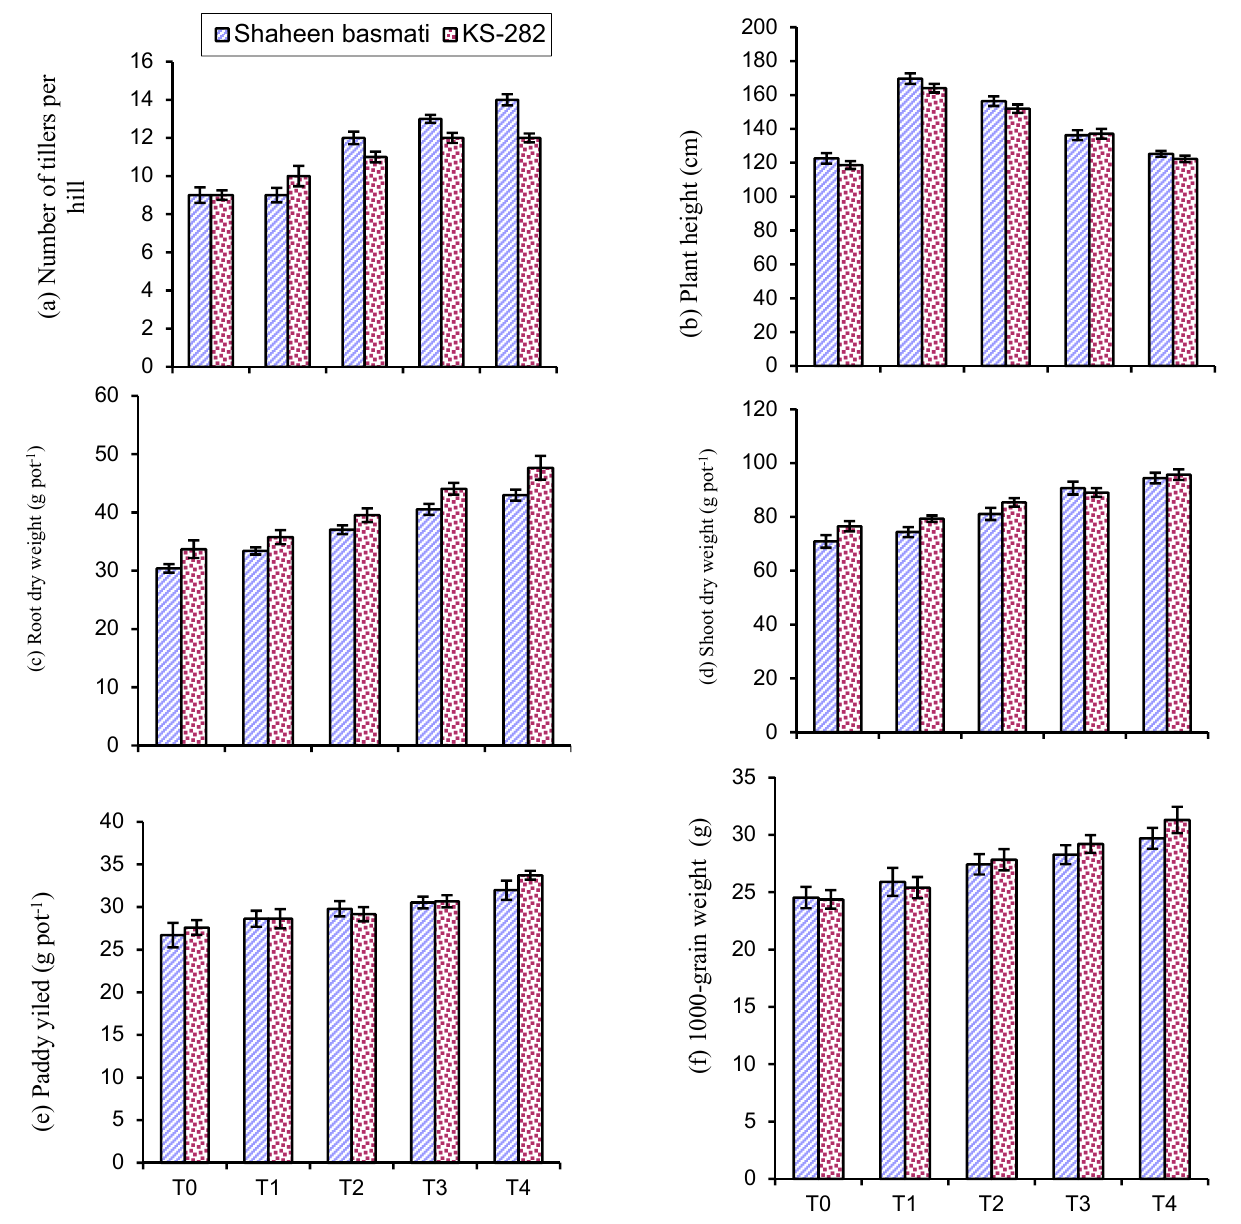
Figure 1. Effect of varying application rates of phosphatic fertilizer on growth and yield responses of rice ( Oryza sativa L.) receiving city effluent irrigation. (Each value is a mean, n = 3 statistically significant at p ≤ 0.05, T bars represents ± SE of means, i.e., SEMs). Whereas, T 0 = Control, T 1 = N 170 P 62 K 62, T 2 = N 170 P 124 K 62, T 3 = N 170 P 186 K 62, and T 4 = N 170 P 248 K 62. Maximum plant height (169.6 cm) and (164.0 cm) was recorded in Shaheen basmati and KS-282, respectively, with T 1 treatment while minimum with T 0 treatment (control).